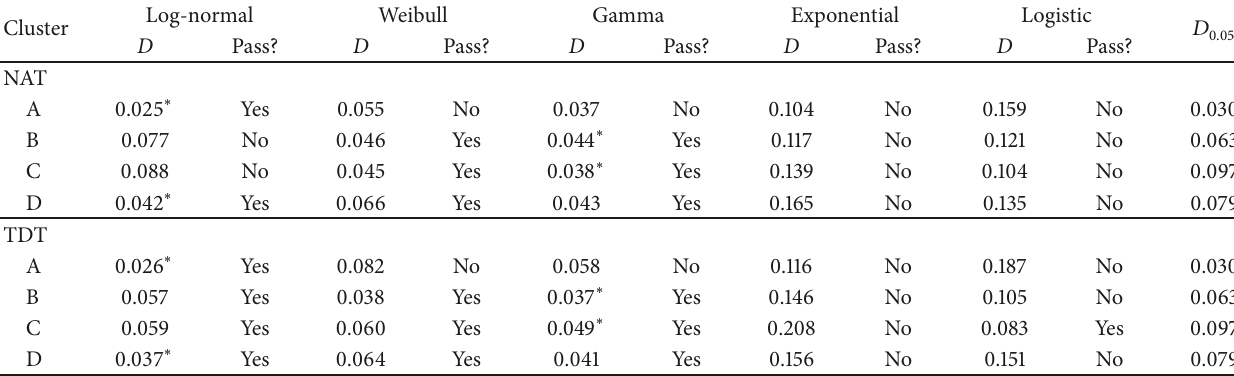
Table 5: Goodness-of-fit testing of NAT and TDT using K-S method.